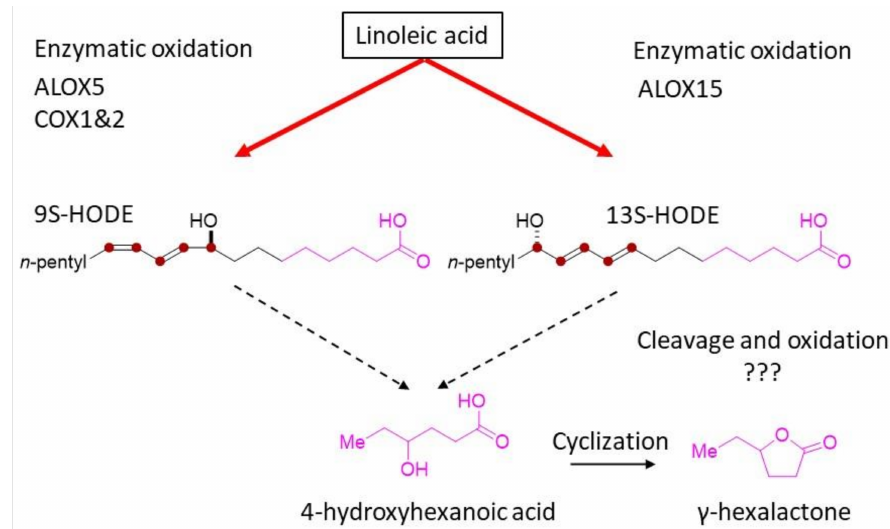
Figure 6. Proposed pathway of γ -hexalactone related to the sweet aroma of beef via enzymatic reaction. We propose a pathway for the formation of γ -hexalactones via intermediates 9S-HODE or 13S-HODE, which are produced from free linoleic acid in beef by enzymatic oxidation. These hydroxy fatty acids may be further degraded to 4-hydroxyhexanoic acid through cleavage and oxidation reactions, and then to γ -hexalactone by cyclization reactions. Question marks (???) indicates an unknown chemical reaction